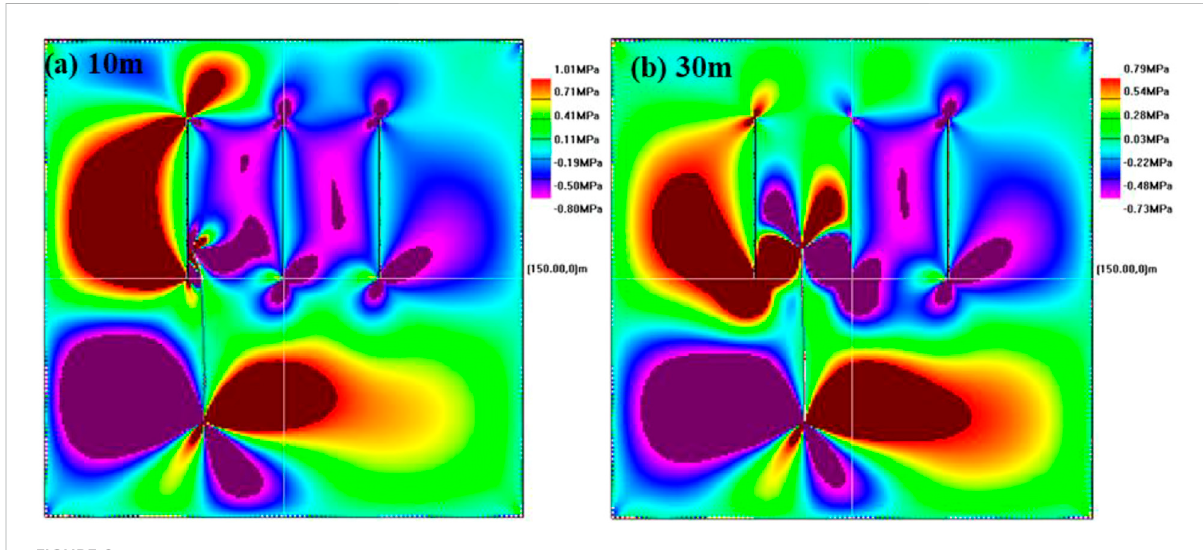
FIGURE 8 Distribution of shear stress fi eld for single arti fi cial fracture